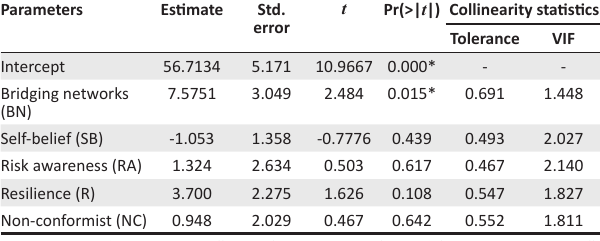
TABLE 4: The significant endogenous variables influencing SME success ( n =